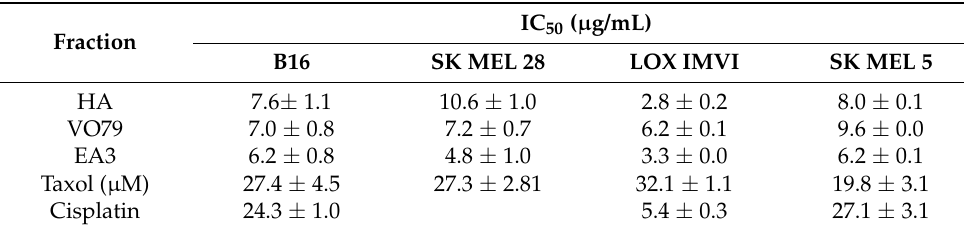
Table 1. IC 50 values of the HA, VO79, EA3 fractions (µg/mL) against murine (B16) and human (SK MEL 28, LOX IMVI, and SK MEL 5) melanoma cell lines. NB: IC 50 values are presented with mean ± Standard deviation. Taxol and cisplatin are positive controls.